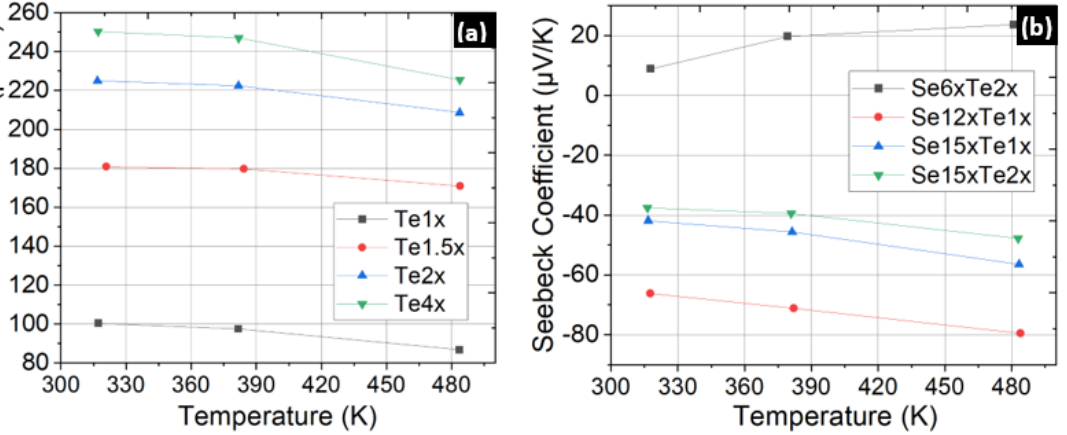
Figure 6. ( a ) Power factor of p-type thin films showing the correlation between the Te composition in the pellets and the thermoelectric performance. All samples were baked for 24 h at 250 °C before measurement. ( b ) Seebeck coefficient measured for n-type thin films prepared with the pellet com- positions stated in the legend. Poor quality n-type thin films with Seebeck coefficients below − 80 µV/K were observed, and a mildly positive S was seen for the Se6xTe2x case.